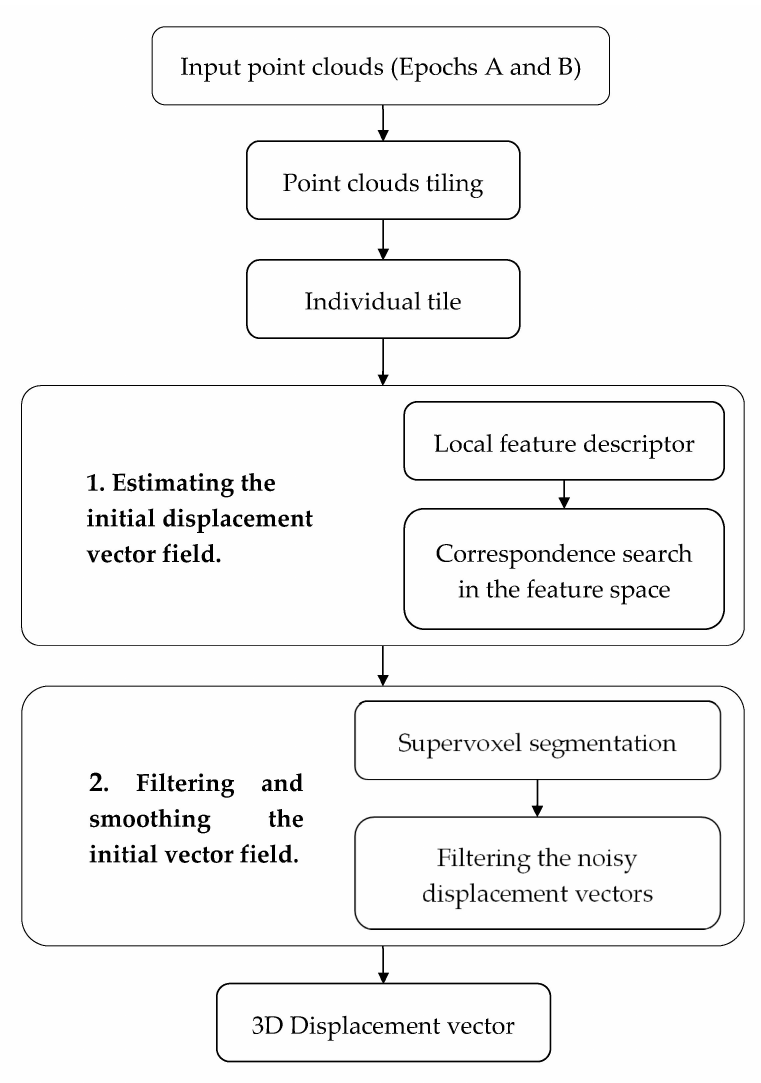
Figure 9. Workflow of the modified F2S3, as described in